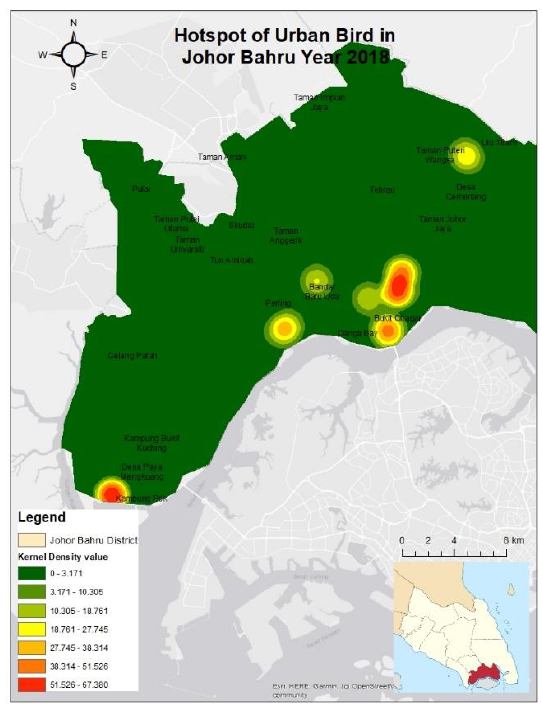
Figure 5 Urban Bird distribution for year 2018